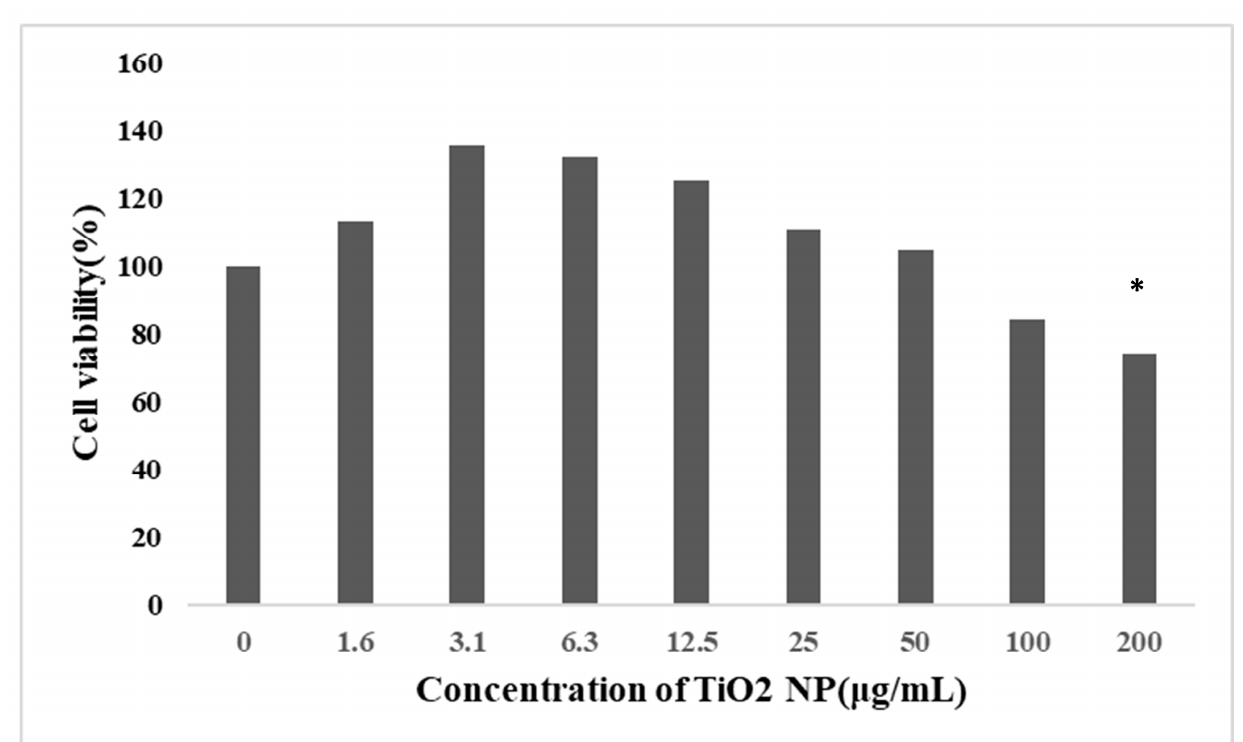
Figure 2. Effect of TiO 2 NPs on the viability of HepG2 cells (mean ± SD, n = 3). Each group set up three repeat biological samples. HepG2 cells were treated with TiO 2 NPs at 0, 1.5625, 3.125, 6.25, 12.5, 25, 50, 100, and 200 μ g/mL for 48 h. The cell viability was significantly decreased in the treatment groups at a concentration of 200 μ g/mL. Cell viability did not decrease in a dose-dependent relationship. Significant difference from the control (* p < 0.05).